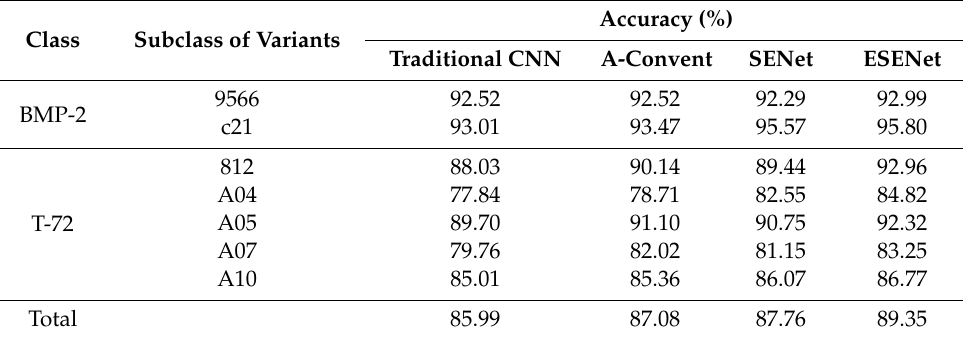
Table 11. Recognition accuracy comparison under EOC2 (version variants).